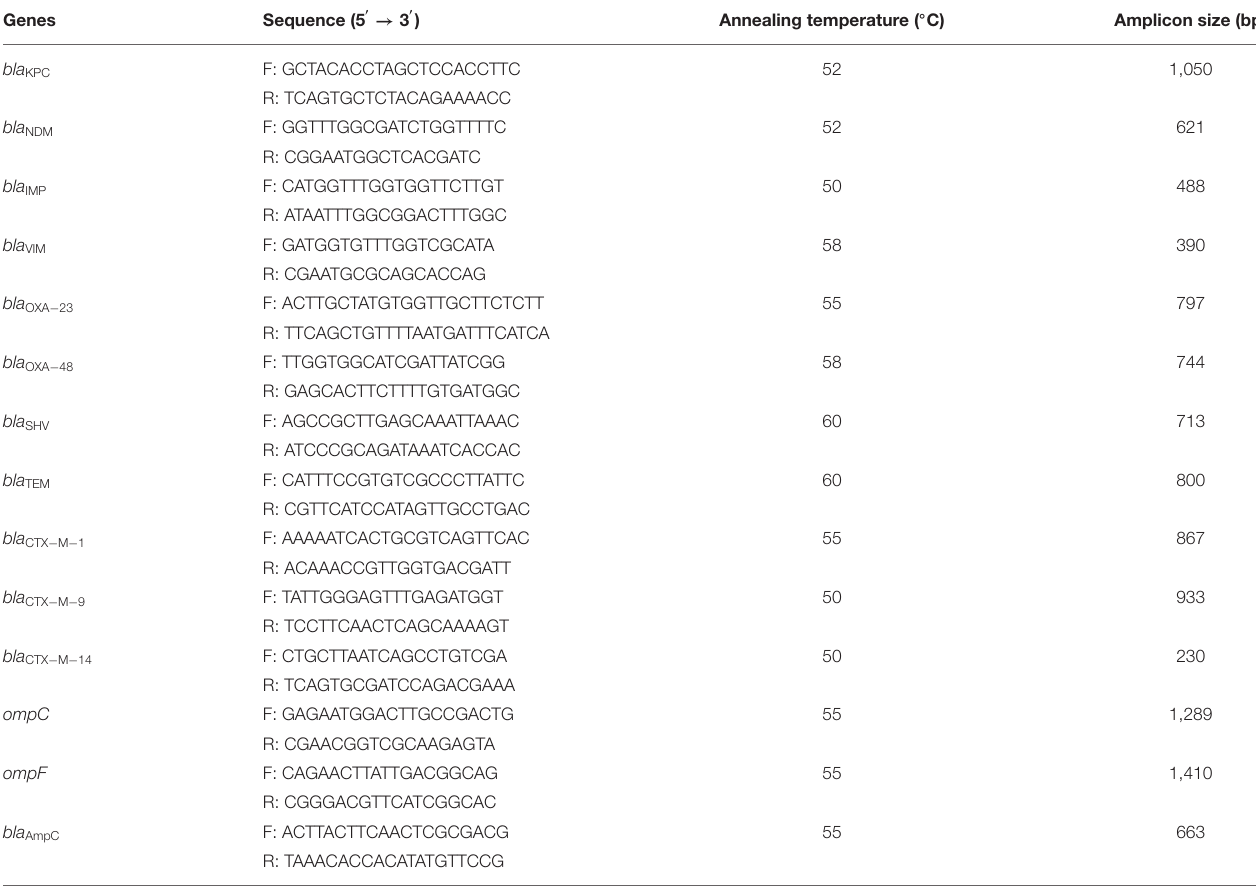
TABLE 1 | PCR primers used in this study. Genes Sequence (5 ′ → 3 ′